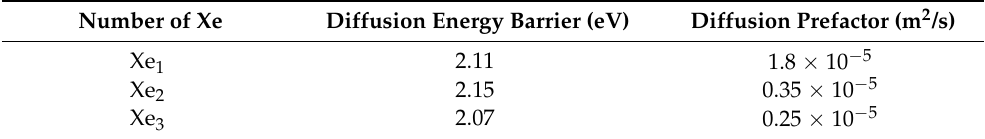
Table 1. Diffusion energy barrier and diffusion prefactor of small interstitial Xe clusters in UO 2 . Number of Xe